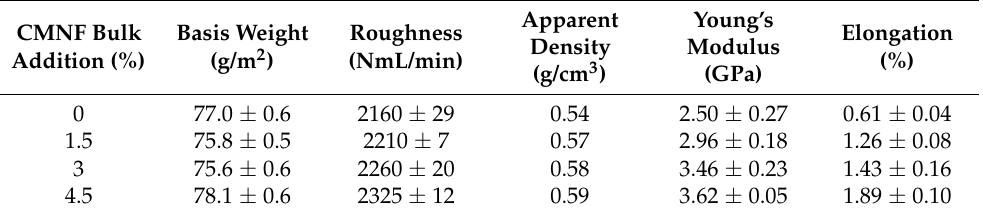
Figure 2. Visualization of the effect of bulk addition. SEM images of: ( a ) the surface of paper, for a magnification of 1000×, without any micro-/nanofibers addition; ( b ) the surface of paper with 1.5 wt.% CMNFs (in bulk); ( c ) the surface of paper with wt.4.5% CMNFs (in bulk); ( d – f ) cross-sectional views corresponding to ( a – c ), respectively, at a magnification of 150×. Table 1. Paper properties, other than those represented in Figure 3, of sheets containing micro-/nanofibers in bulk. The amplitude of the intervals is twice the standard deviation.